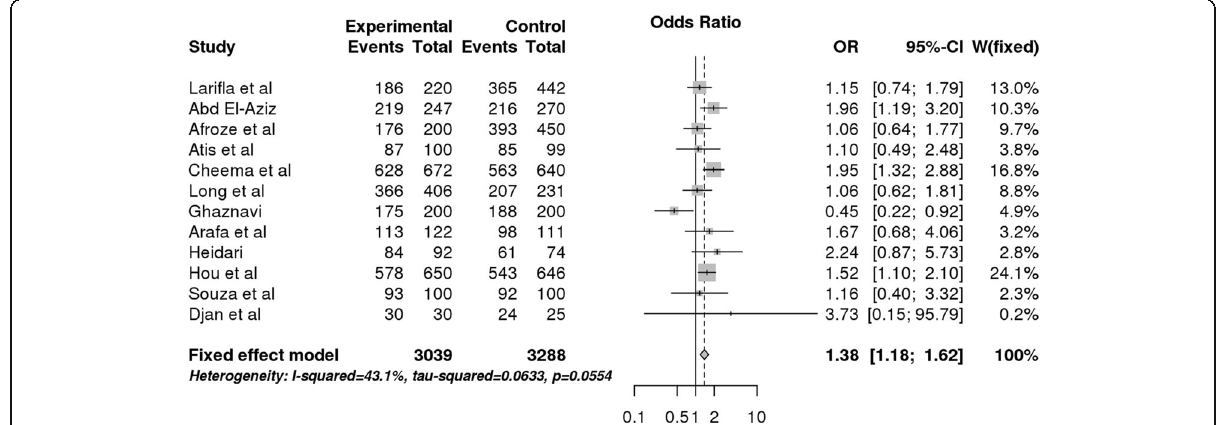
Fig. 2 Forest plot for APOE polymorphism and CAD risk in the genetic model of ε 2 allele analysis